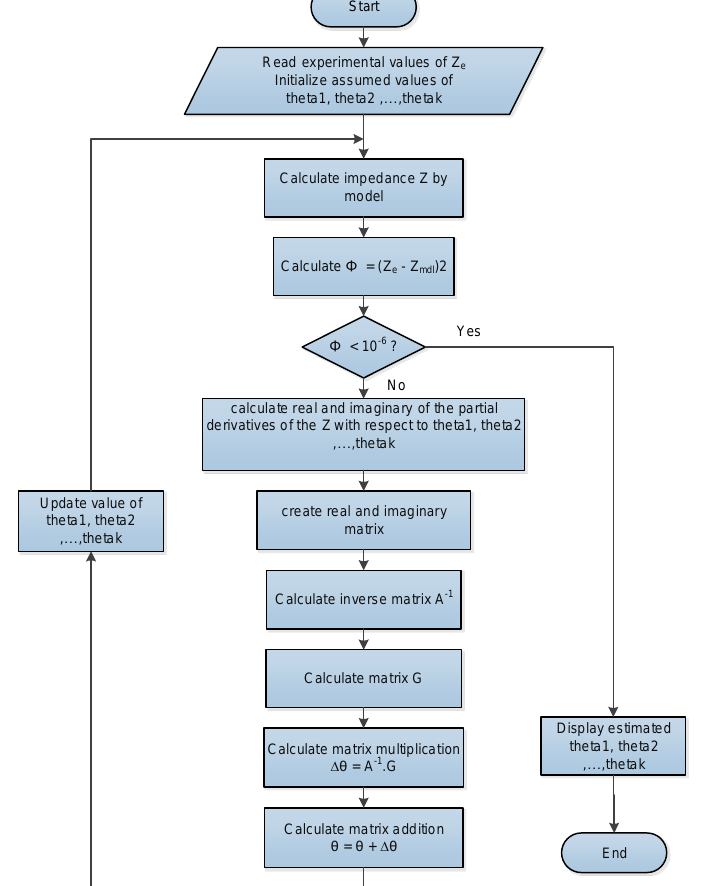
Figure 14. Flow chart for the procedure of complex non-linear least square method.